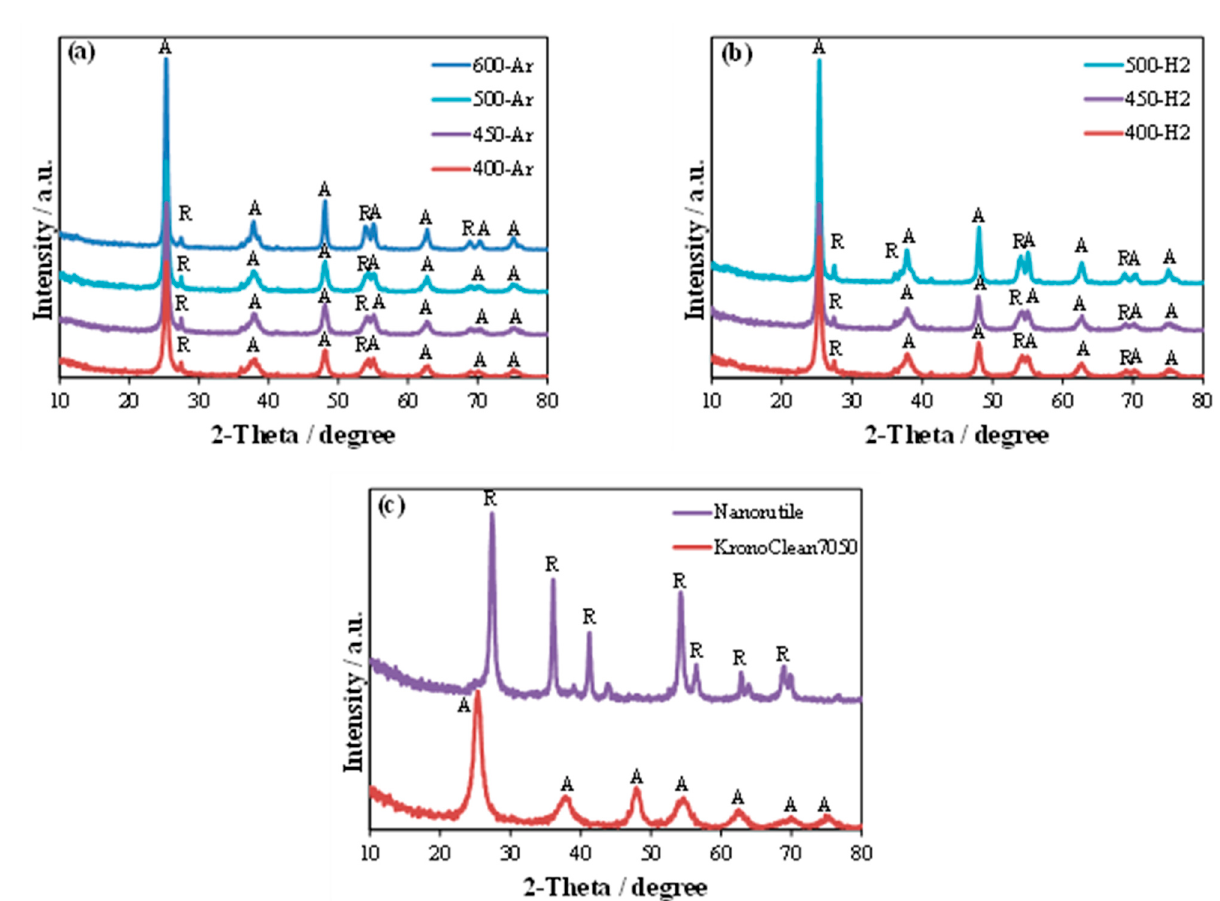
Figure 1. XRD patterns of: ( a ) samples heat treated under argon in 400–600 °C, ( b ) samples heat treated under hydrogen in 400–500 °C, ( c ) commercial samples.